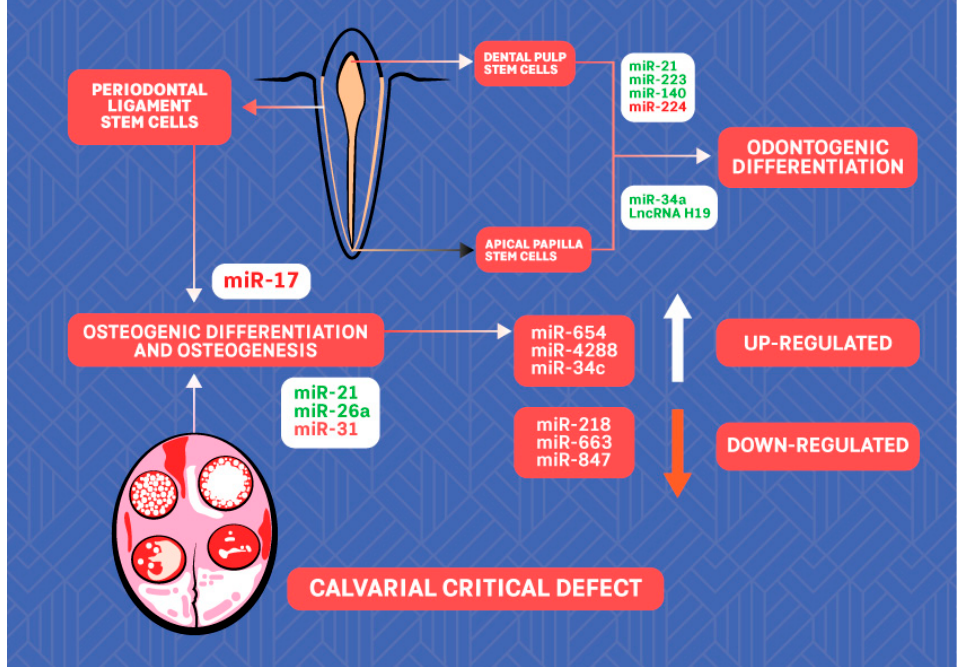
Table 5. Bioinformatic analysis ( miRnet) of miRs involved in the regulation of odontogenic dif- ferentiation of human dental pulp and apical papilla stem cells showing the top four target genes with the highest degree in the miR-mRNA regulatory network.